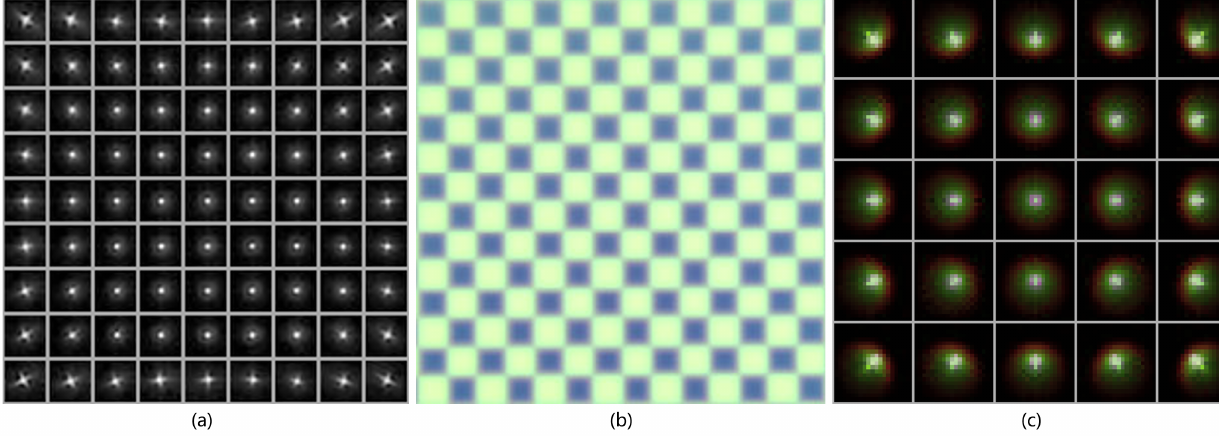
Figure 3. ( a ) The PSF distribution of the harmonic diffractive lens with a wavelength of 500–600 nm on the focal plane; ( b ) PSF estimation experiment of harmonic diffraction imaging system; ( c ) The PSF distribution of the imaging system measured